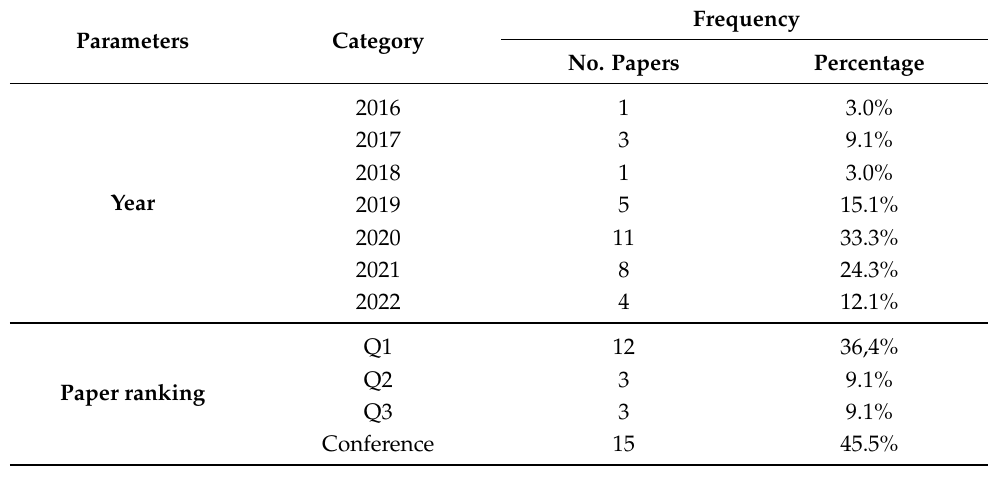
Table 8. Number and frequency of year and paper ranking.